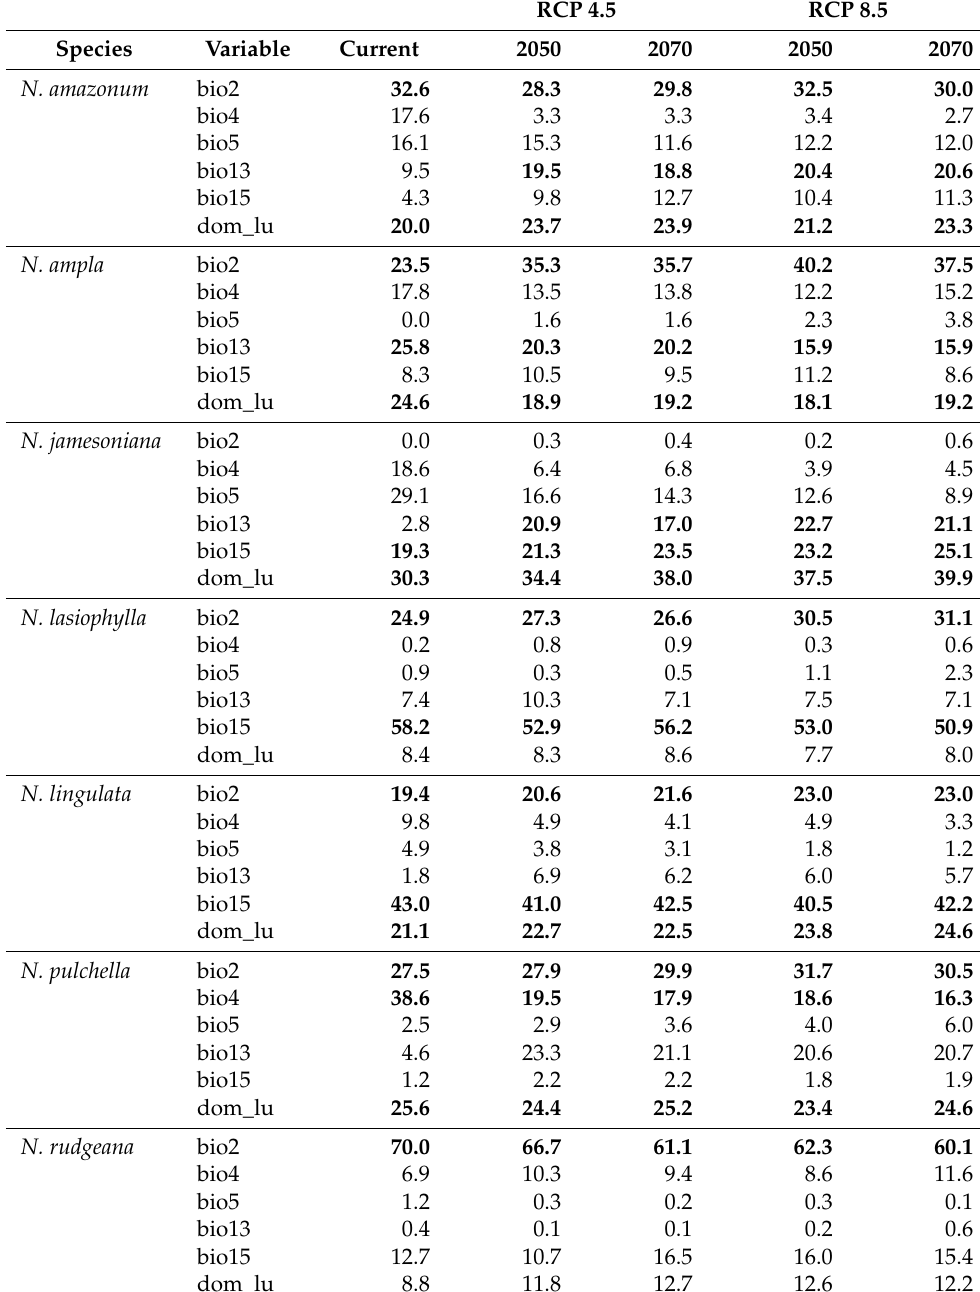
Table 4. The mean relative contribution for the six bioclimatic variables used for the habitat suitability modeling of the water lily species in South America in two representative concentration pathways (RCPs 4.5 and 8.5) and two scenarios (2050 and